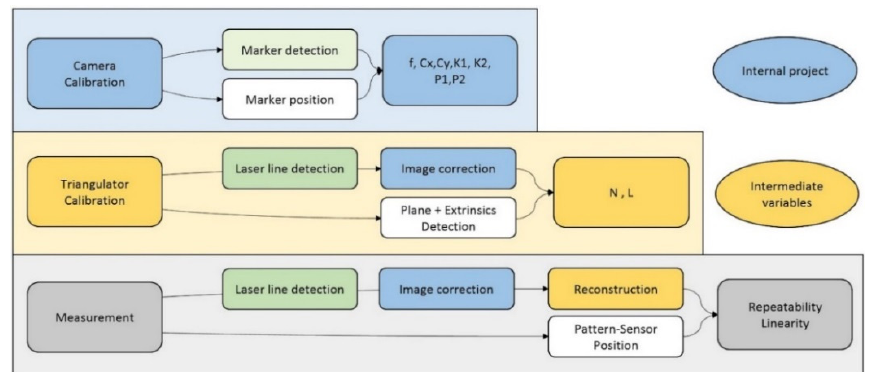
Figure 4. Flow chart for experiments, with each block divided into different phases. Each output obtained in camera and laser calibrations is used as an input for block measurements. For camera calibration, the final outputs are the intrinsic parameters, which are the focal length (f), centre of distortions (Cx, Cy), and calibration parameters (K1, K2, P1, P2). Both N and L are triangulator calibration parameters defining the laser position in space.